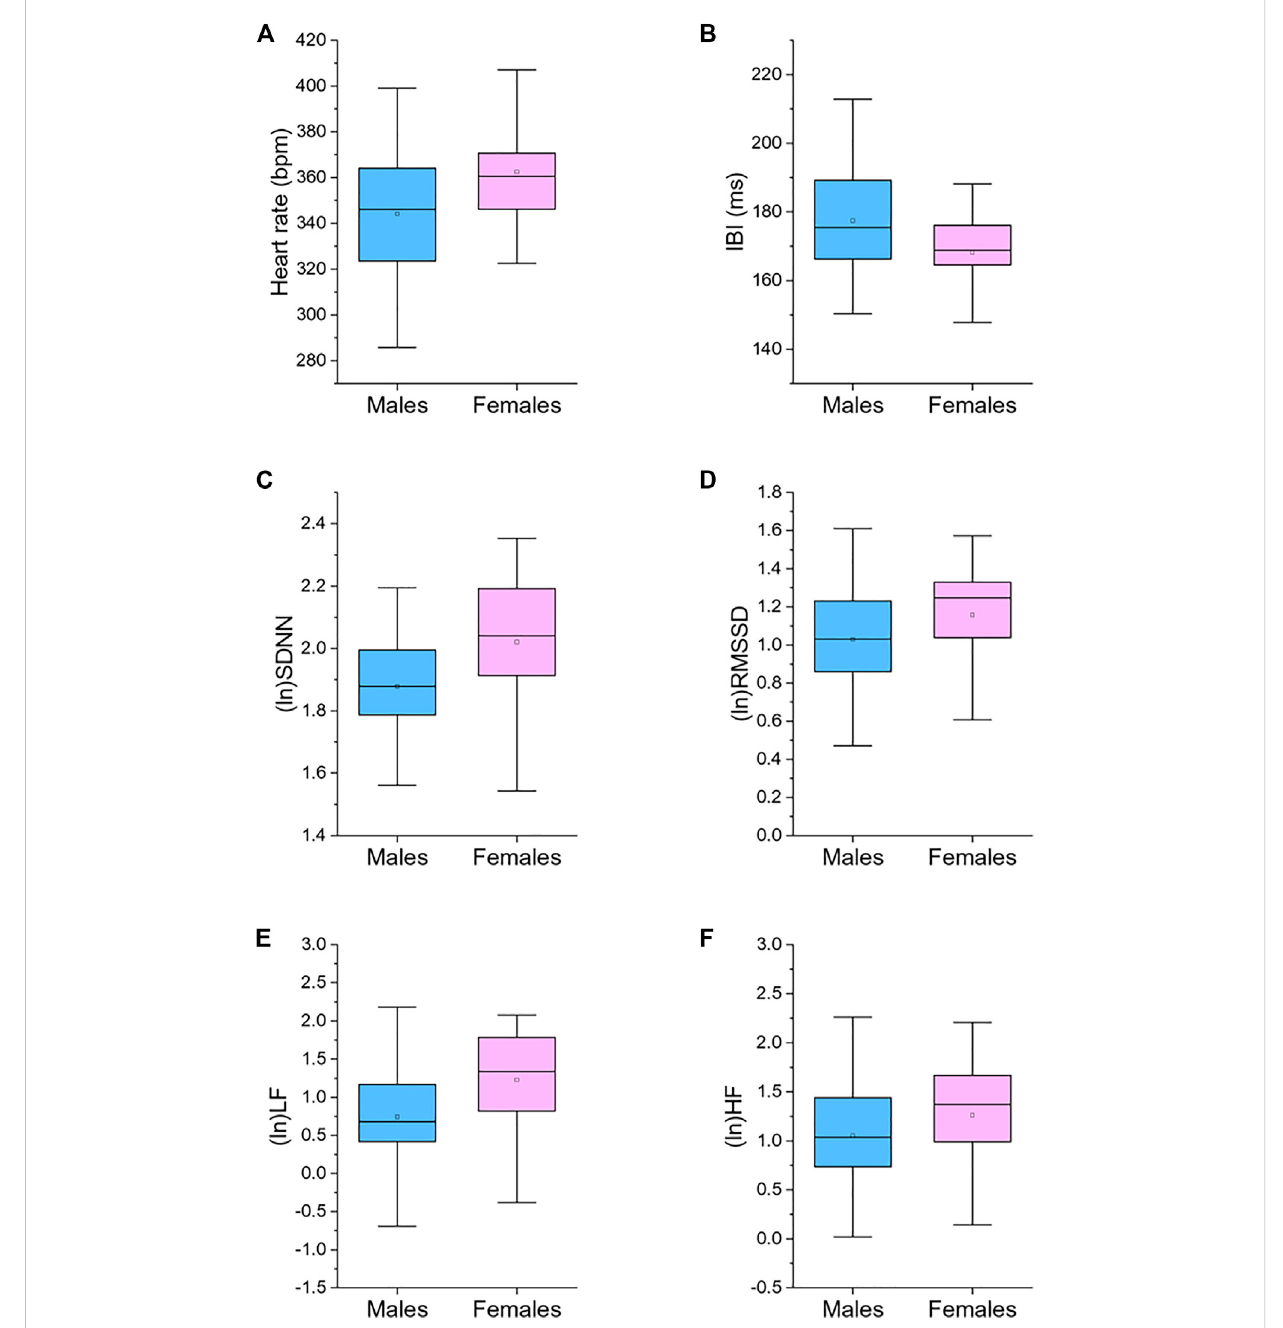
FIGURE 1 Boxplotsfor24-hvaluesofheartrate (A) ,inter-beatinterval(IBI, (B) ),standarddeviationofIBIs(SDNN, (C) ),rootmeansquareofsuccessivebeat-to- beat interval differences (RMSSD, (D) ), low frequency power (LF, 0.2 – 0.75 Hz; (E) ), and high frequency power (HF, 0.75 – 2.5 Hz; (F) ), divided by male ( n = 87) and female ( n = 45) rats. The boxes show the data between the 25th and 75th percentile, the middle line represents the median, the black dot represents the mean. Ln, natural logarithm. Statistics are reported in Table